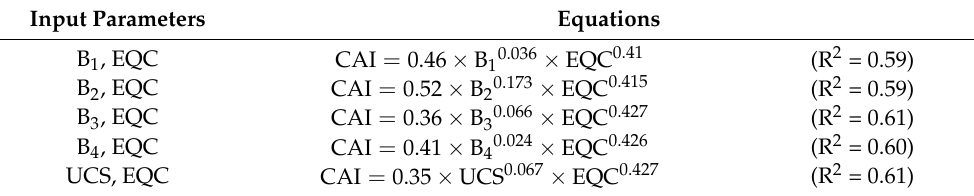
Table 7. Prediction models for the Cerchar abrasiveness